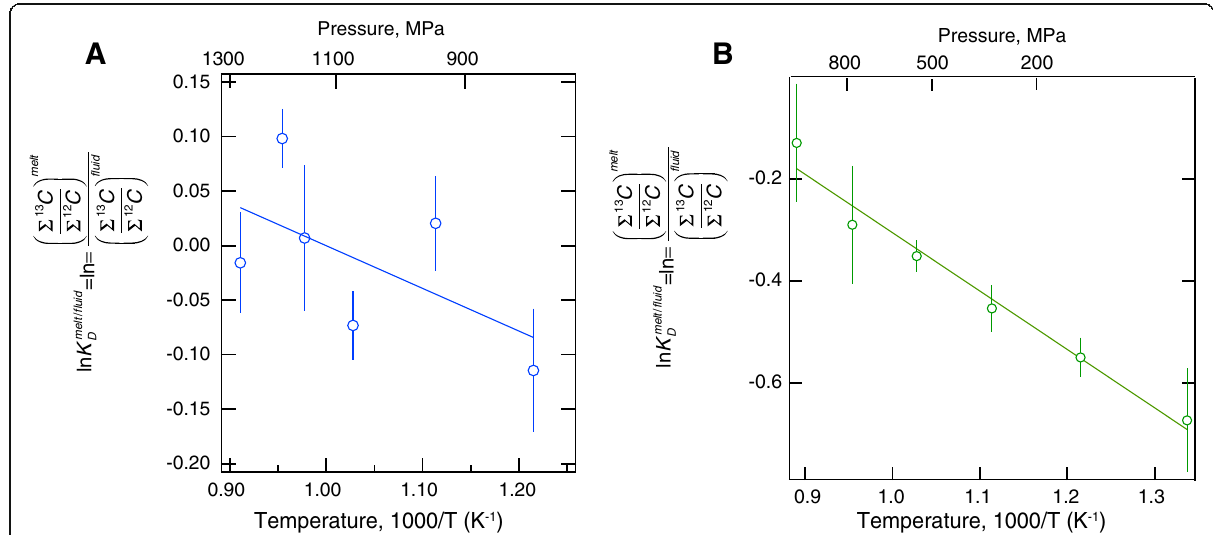
Fig. 10 Carbon isotope melt/fluid exchange equilibrium coefficient in silicate – COH systems as a function of temperature and pressure. a Under oxidizing conditions with all carbon residing in CO 32 − and HCO 3 − groups. Note that these redox conditions are similar to those of Mattey (1991) and Mattey et al. (1990) who reported log values in the 0.09 to − 0.83 range in the 1200 – 1400 °C range depending on silicate composition. b Under reducing conditions with all carbon residing in CH 4 and/or CH 3 groups. The Δ H values from these slopes are reported in Table 1. Data otherwise from Mysen (2016,